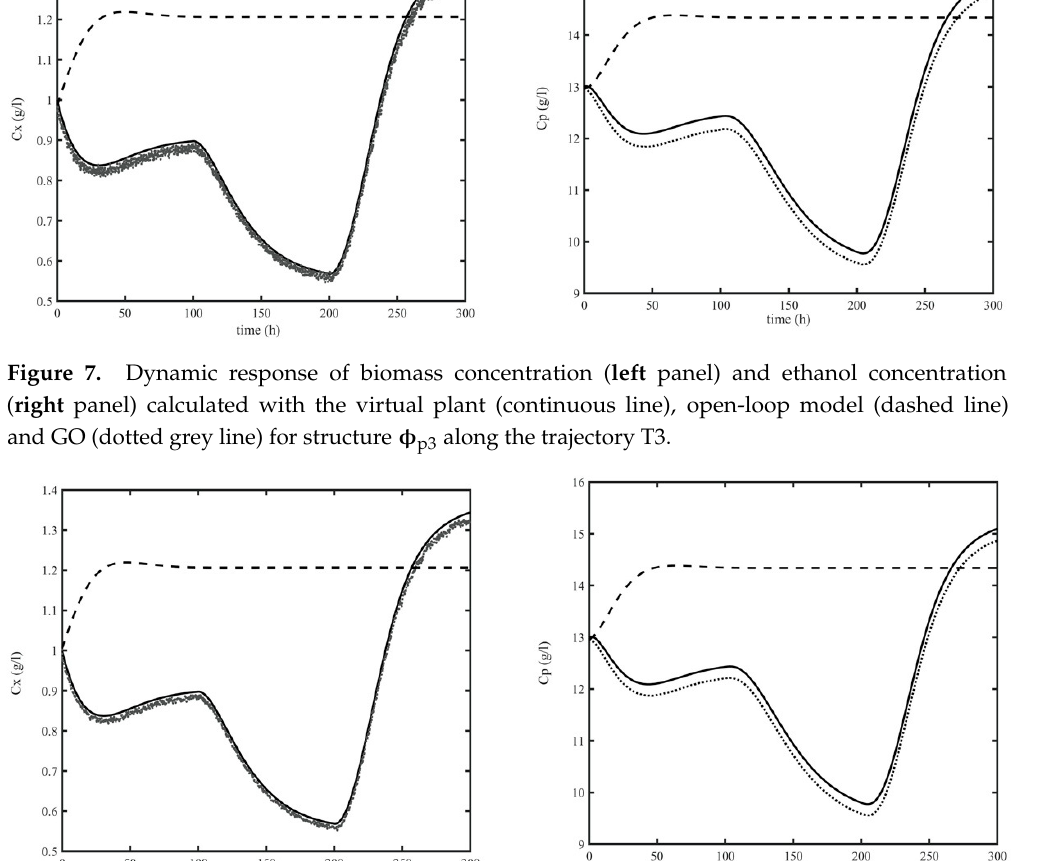
Figure 7. Dynamic response of biomass concentration ( left panel) and ethanol concentration ( right panel) calculated with the virtual plant (continuous line), open-loop model (dashed line) and GO (dotted grey line) for structure 𝛟 (cid:2926)(cid:2871) along the trajectory T3.